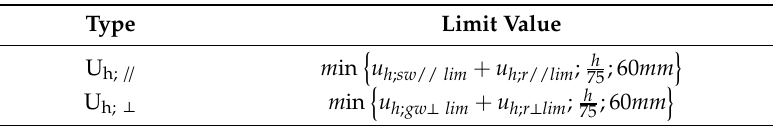
Table 7. Limits of horizontal